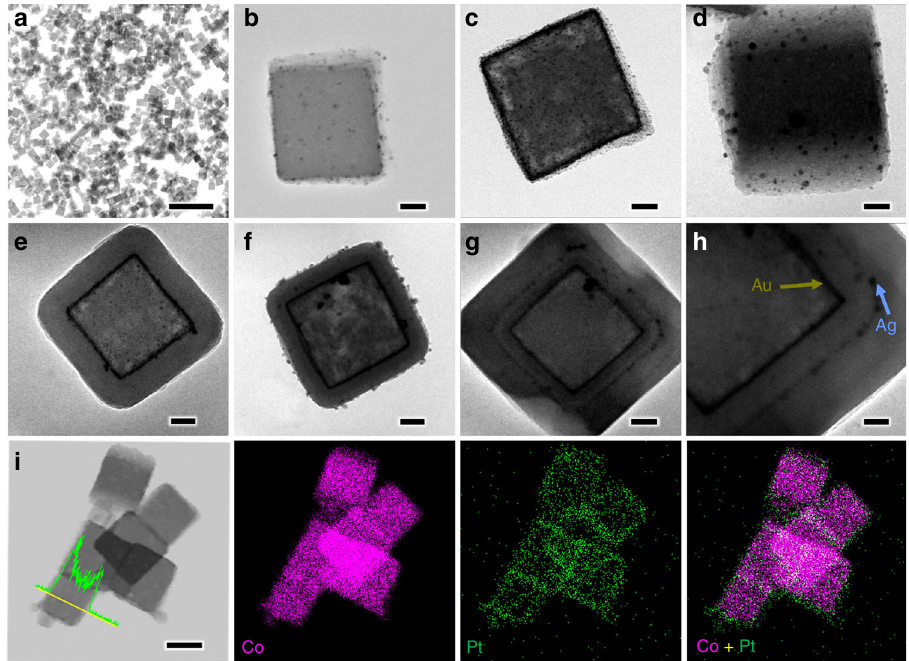
Fig. 5 Characterizations of ZIF/metal nanocomposites. a , b TEM images of ZIF-67/Pt, c TEM image of ZIF-67/Au, d TEM image of ZIF-67/Ag, e TEM image of ZIF-67/Au@ZIF-8, f TEM image of ZIF-67/Au@ZIF-8/Ag, g , h TEM image of ZIF-67/Au@ZIF-8/Ag@ZIF-67, and i EDX elemental maps and line scans of ZIF-67/Pt. Colour codes: green represents Pt; pink represents Co. More characterization results of the ZIF/metal nanocomposites can be found in Supplementary Figs. 16-20. Scale bars in a – i are 1000, 30, 30, 30, 60, 80, 100, 50 and 100 nm,